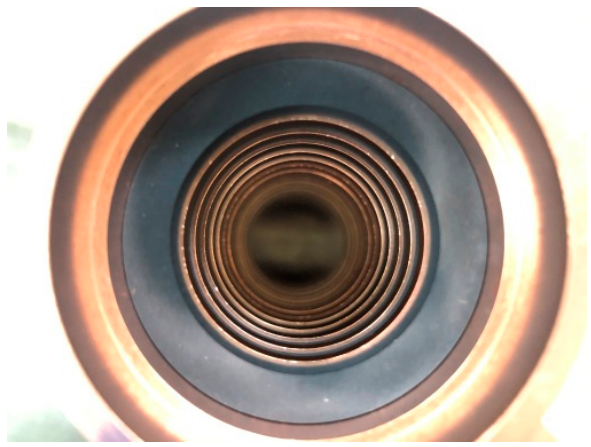
Figure 6. Image of the optimized beam tunnel structure.